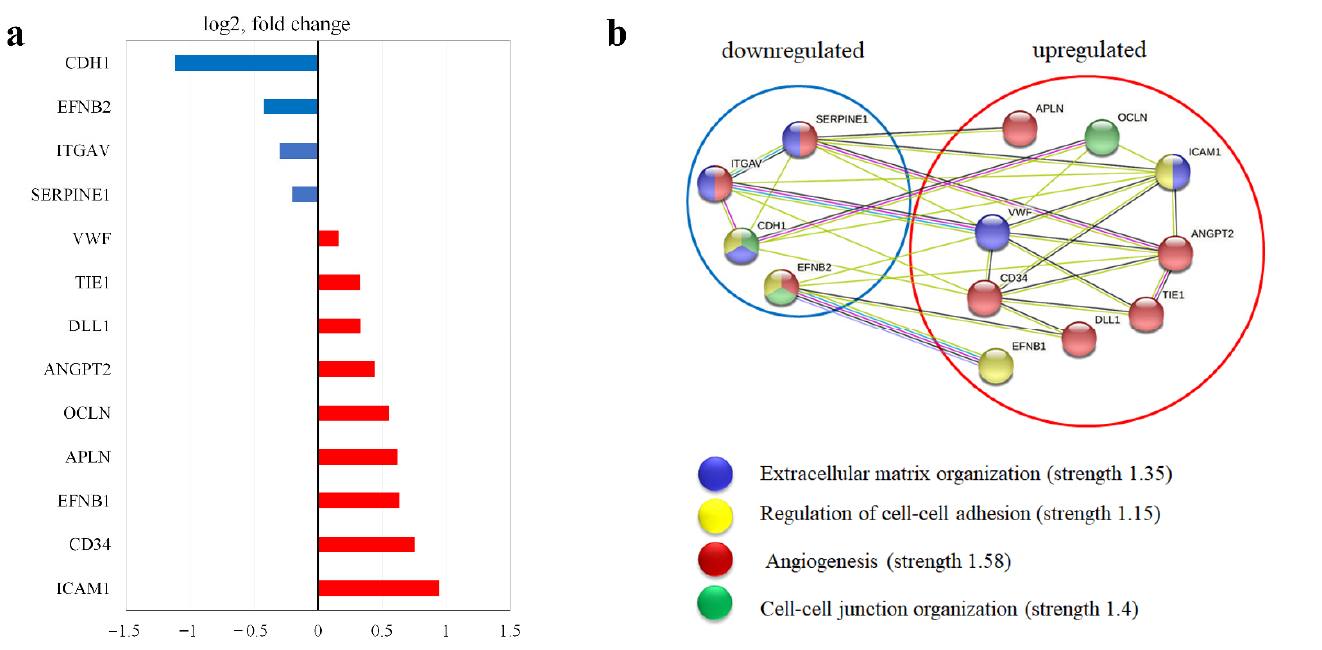
Figure 8. Input of EM synthesized by MSCs as a monoculture on gene expression of further co- culture with HUVECs. MSCs were grown as a monoculture for 48 h (“48 hold MSCs”) to allow synthesis/secretion/assembly of FN fibrils. HUVECs preloaded with CMFDA (green) were then seeded on top of “48 h-old MSCs” and co-cultured for an additional 19 h. Cells in direct co-culture were separated using anti-CD31 magnetic beads. Total RNA was isolated and specific mRNA levels were quantified by qRT PCR as described in “Methods”. The data are presented as fold changes in the mRNA levels of HUVECs in co-culture with “48 h-old MSCs” MSCs compared to the mRNA levels for the HUVECs in 19 h co-culture with “0 h-old MSCs”. ( a ) Fold changes in the expression significantly altered mRNA presented as log2. p < 0.05, n ≥ 3 experiments. ( b ) Functional protein association networks analysis was performed in STRING [9].